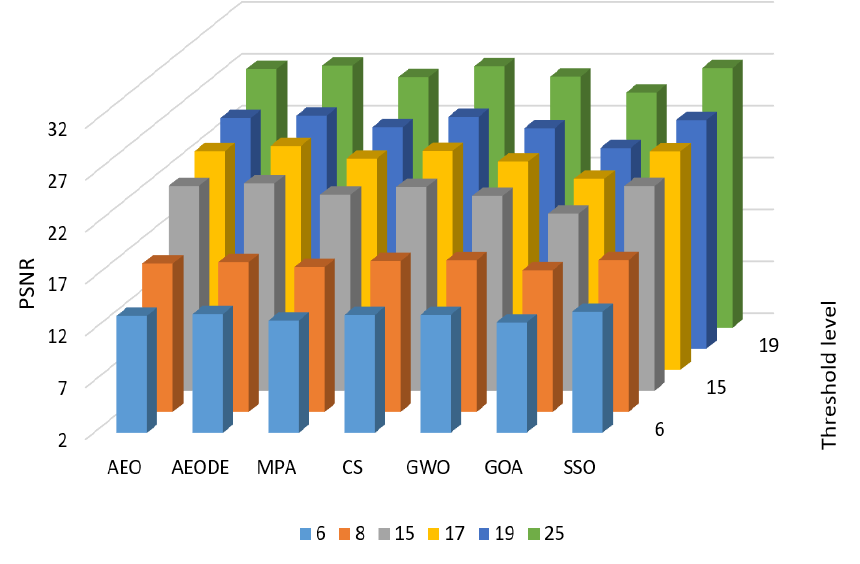
Figure 5. PSNR at different threshold